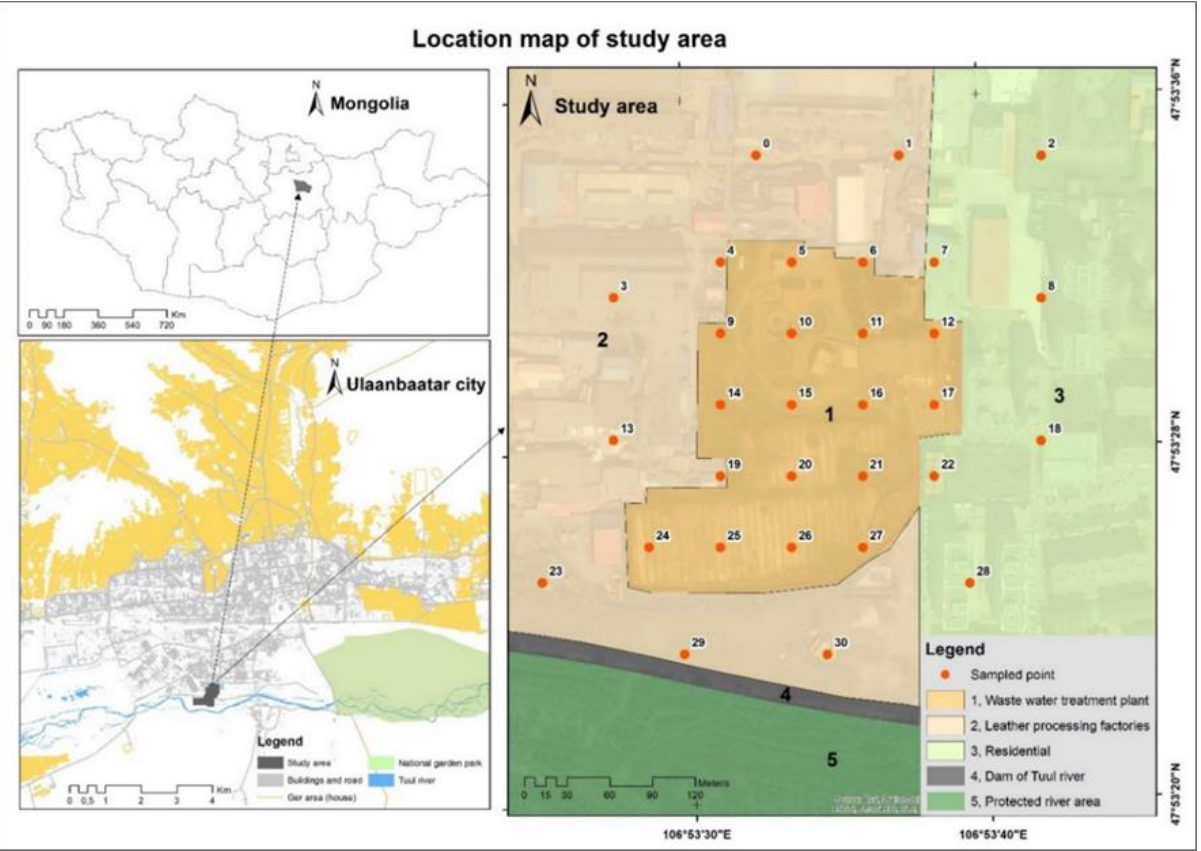
Figure 1 . Location map of study area. (Industrial area, Ulaanbaatar,